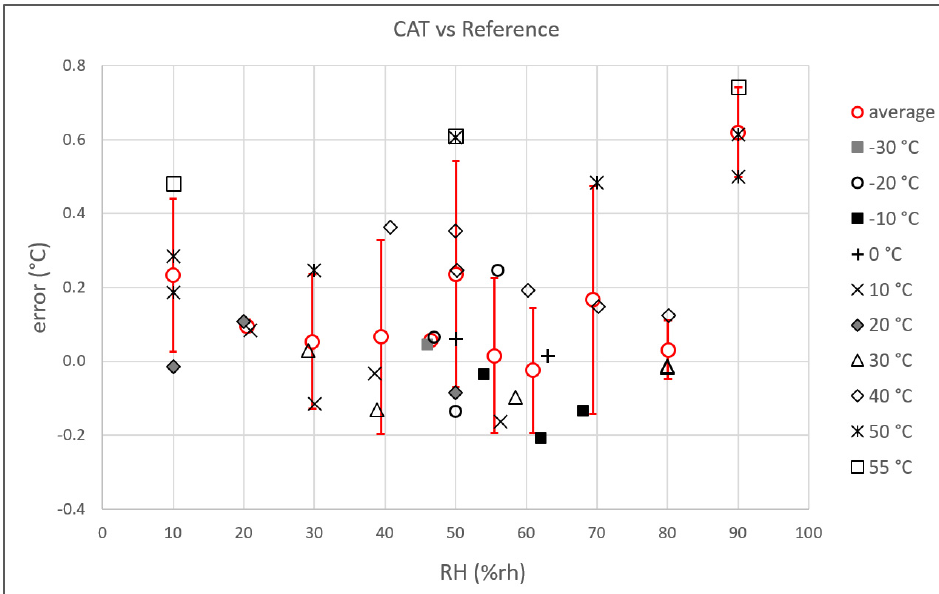
Figure 9. Summary of the results: the measurement difference between the CAT and the reference thermometers is plotted vs. the relative humidity. The temperature of each individual measurement is indicated in the legend. The red circles represent the average of the results grouped for each relative humidity value. The vertical red bar is the standard deviation of the measurements.